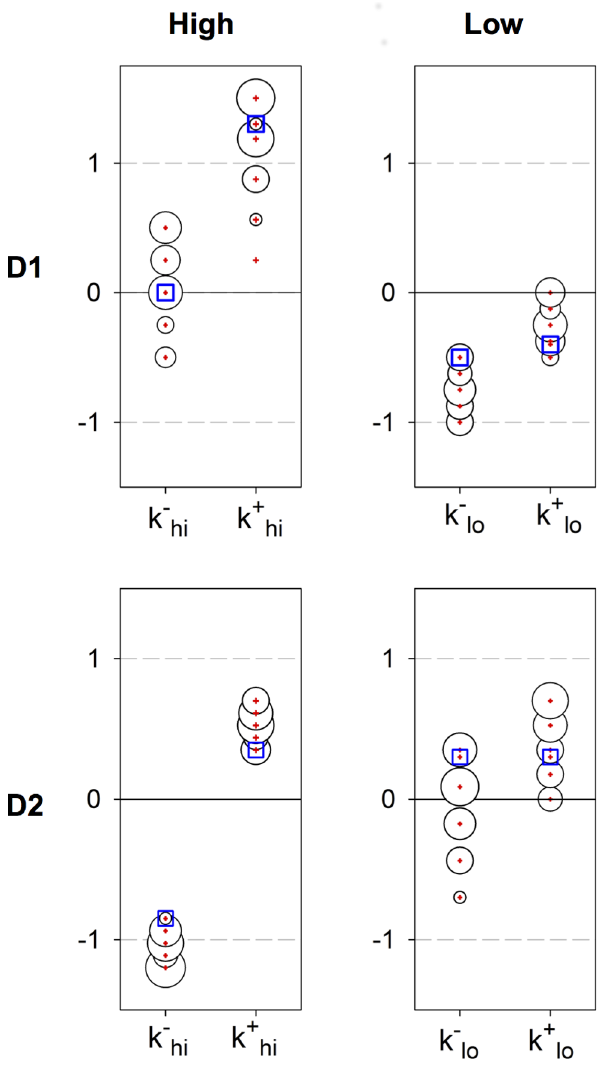
Figure 10. Results of exhaustive search of plasticity coefficients for the STDE model. The plot layout corresponds to that in Figure 4. In each plot, the red crosses show the coefficient value, the area of the bubble is proportional to the number of times that value was found, and the blue squares are the hand-chosen values used to create the activity profiles in Figure 7. The discovered set for D1-MSNs comprised the 26 best profiles from Figure 9D and are reported in the top row. For D2 MSNs, there were 32 candidates with satisfactory profiles at the end of both coarse and focused searches; they yield the plots in the bottom